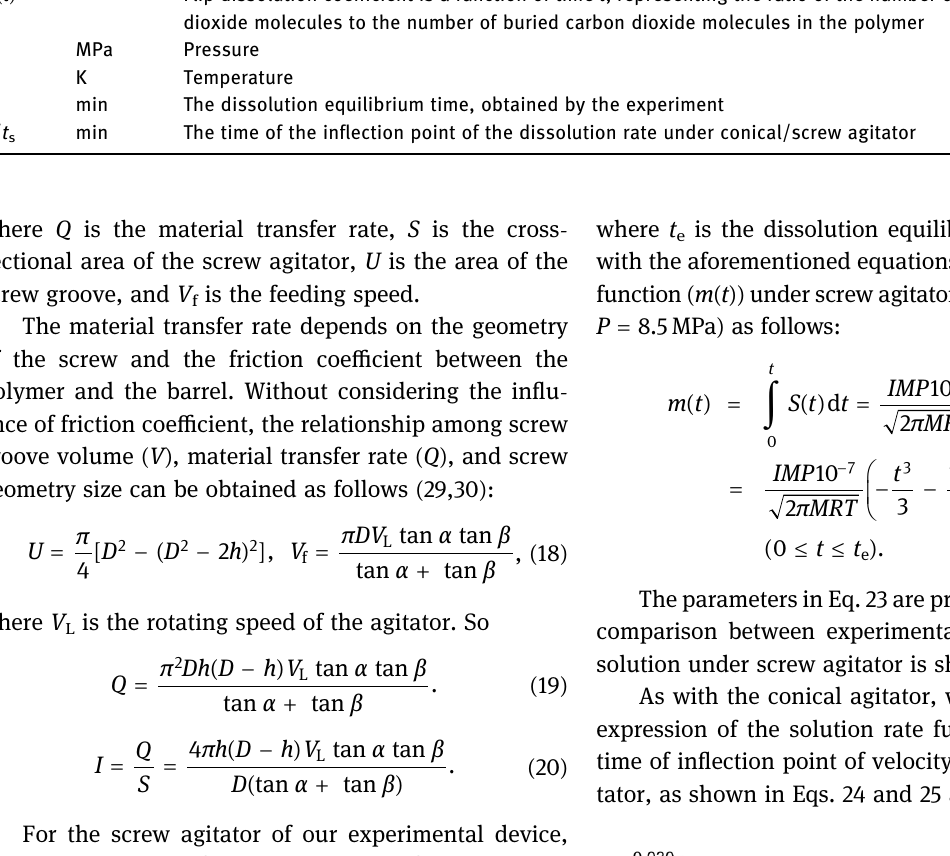
Table 3: Parameter symbol and description Symbol Unit Explain M Constant The mass of the CO R Constant